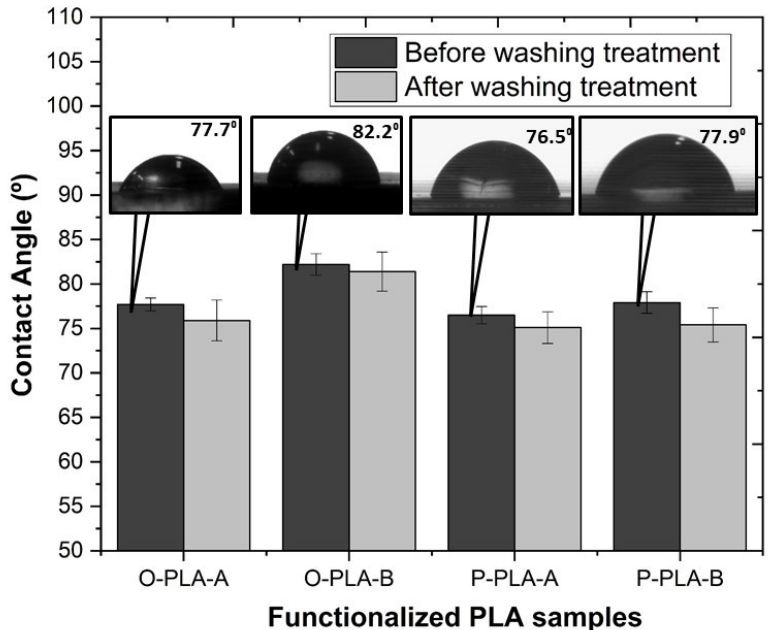
Figure 6. Variation of the water contact angle on the neat and functionalized PLA flat tape samples before and after washing treatment.